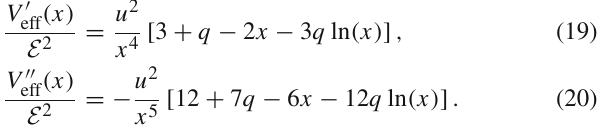
Fig. 2 The event horizon x + (solid line) and Cauchy horizon x − (dashed line) for black holes in Horndeski gravity